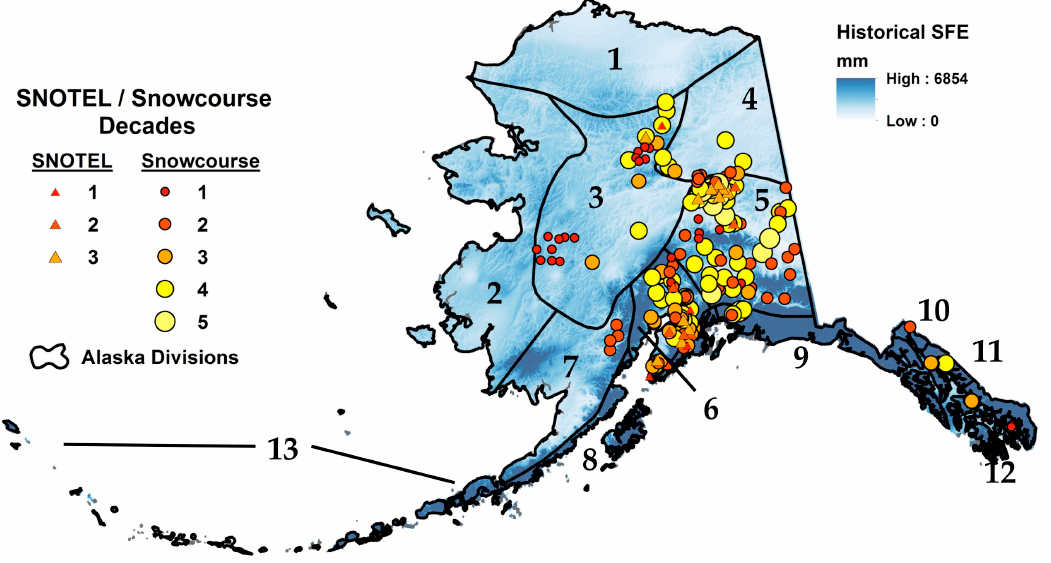
Figure 1. Snow Telemetry (SNOTEL, 21 total) and snowcourse sites (170 total) used in this study, 13 Alaska climate divisions (black boundaries), and 1970–1999 historical snowfall equivalent (SFE). See Table 5 for division